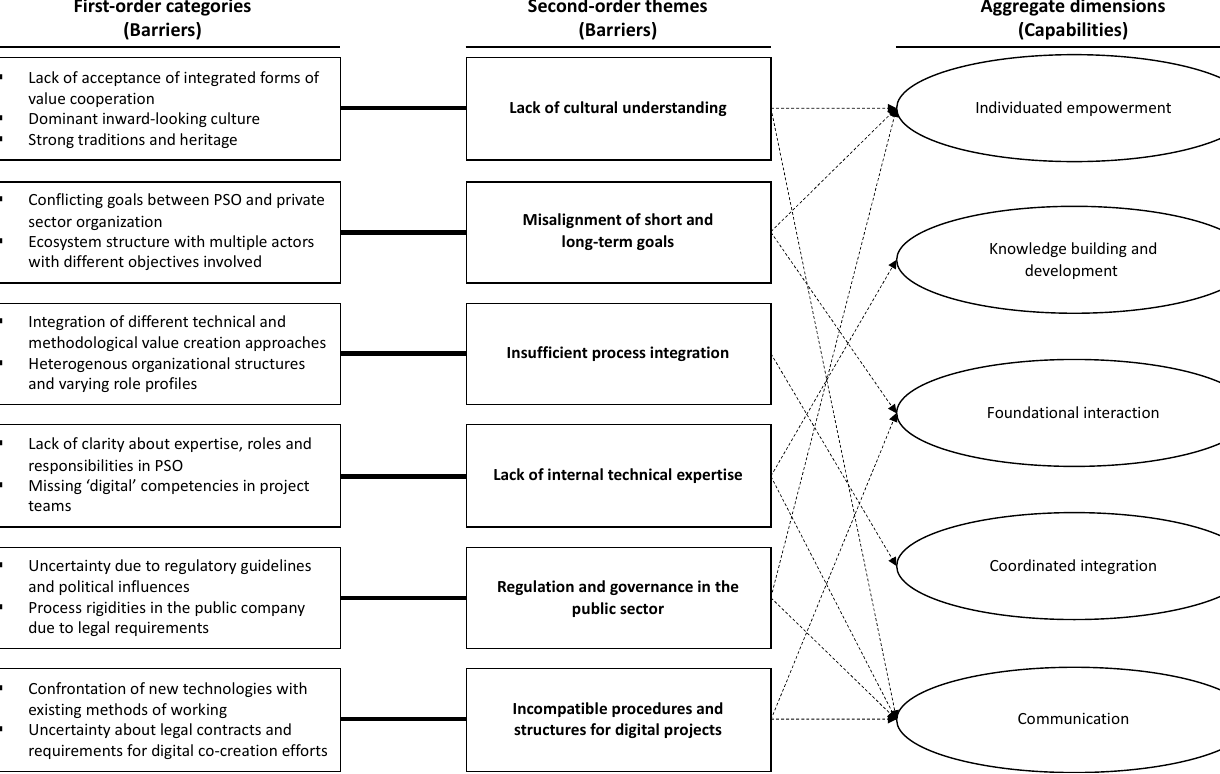
Figure 1. Data structure.